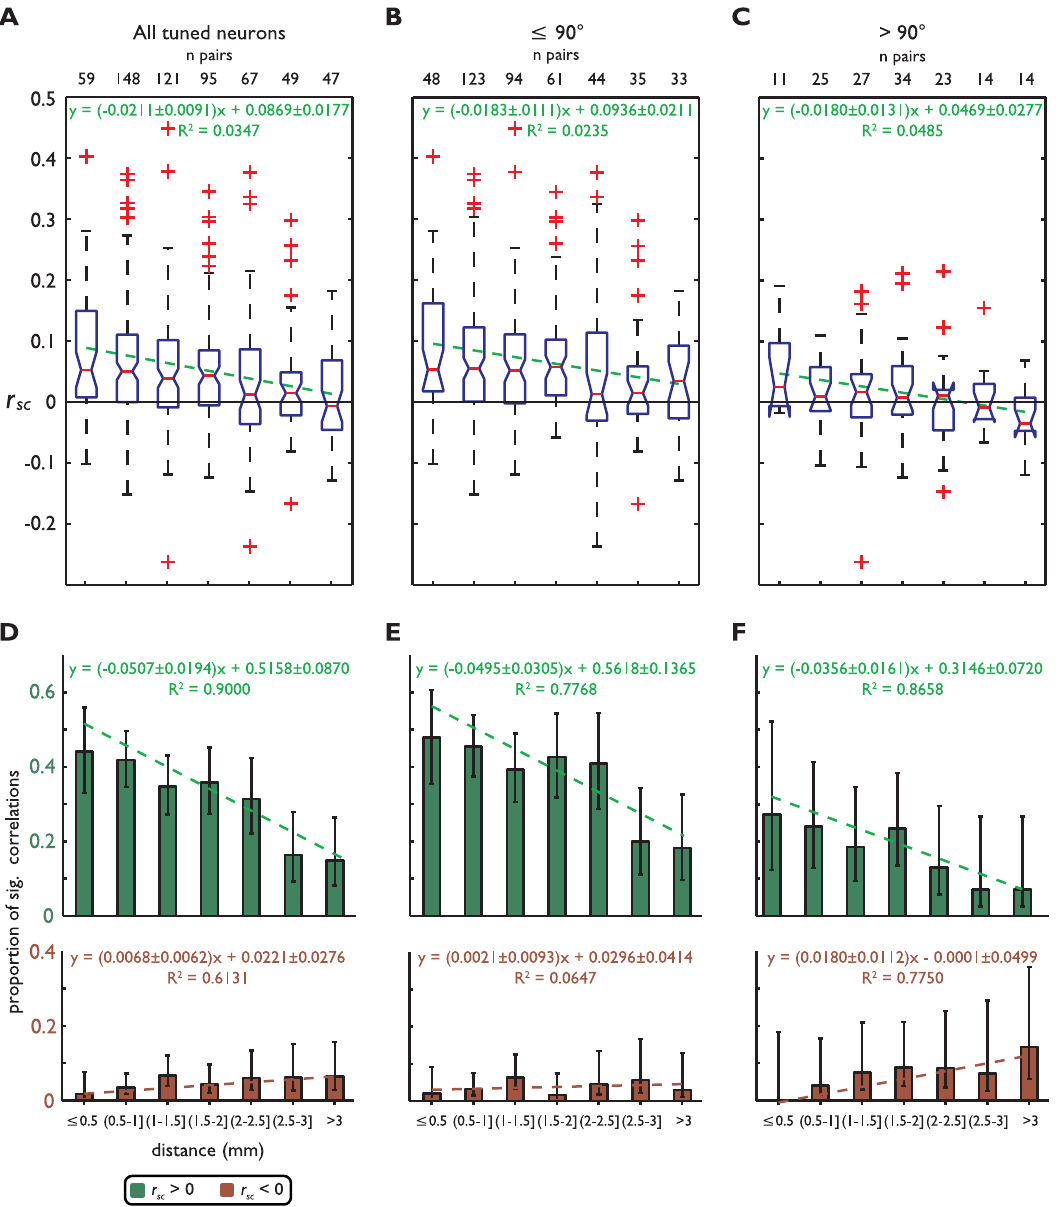
Figure 6. Spike count correlations between visuospatially-tuned neurons as a function of inter-neuron distance. Distributions of r sc (ordinate) as a function of distance between neurons (abscissa). A ) Displays all neurons, B ) neurons with RFs # 90 u apart, and C ) neurons with RFs . 90 u apart. D–F ) Proportion of significant positive and negative r sc and r sc,p (ordinate, see color legend) as a function of distance between neurons (abscissa), organized by distance between RF as in A–C . All symbols are the same as in Figure 4 .